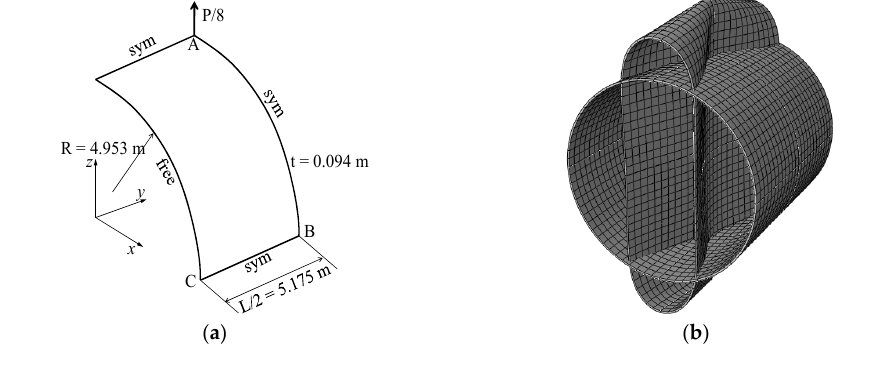
Figure 14. Pull-out of an open-ended cylinder: ( a ) geometry and ( b ) undeformed and deformed configurations.